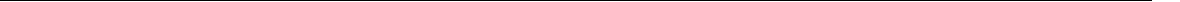
Fig. 2 Isolated genetic variants within GATA1 peaks co-occur with dramatic changes in GATA1 binding and nearby transcription. a Summary of discSNP pairs in GATA1 peaks (200 bp, n = 35,166). b GATA1 ChIP-seq intensity tracks (input and library-size-normalized, identical y -axis scales) reveal dramatic changes in GATA1 binding associated with single-nucleotide variants adjacent to (chr3: 66,455,298 - 66,457,298) or within (chr19: 46,129,935 - 46,131,935) a GATA1 motif (no other discSNPs within 1 kb). Dotted vertical line indicates discSNP position. c GATA1 ChIP-qPCR at native (N) loci in either G1E-ER4 or MEL cells where one cell line contains an intact (I) GATA1 motif and the other cell line has a disrupted (D) motif. A 200-bp region centered on these intact/disrupted motifs was barcoded and cloned into ectopic (E) locations in G1E-ER4 cells and GATA1 ChIP-qPCR was performed at these sites. Mean ± SEM, n = 3. d GATA1 ChIP-qPCR and e RT-qPCR in 5 MEL clones edited at a control locus (WT) or at the Bola1 -proximal GATA1 peak. For d – e , mean ± SEM, n = 3. f For discSNPs found in TSS-proximal GATA1 peaks, Pearson's correlation coef fi cients between delta GATA1 binding and delta transcription at a range of FDR cutoffs for differential binding. g Scatterplot of delta GATA1 binding vs. delta transcription at an FDR cutoff of 1e − 4, PCC = 0.43. h Pearson's correlation coef fi cients between delta GATA1 binding and delta transcription at a range of cutoffs for distance between the GATA1 peak and nearby TSS. For f – h , error bars are 95% con fi dence intervals, * p = 0.03, ** p < 0.001 (Fisher ’ s